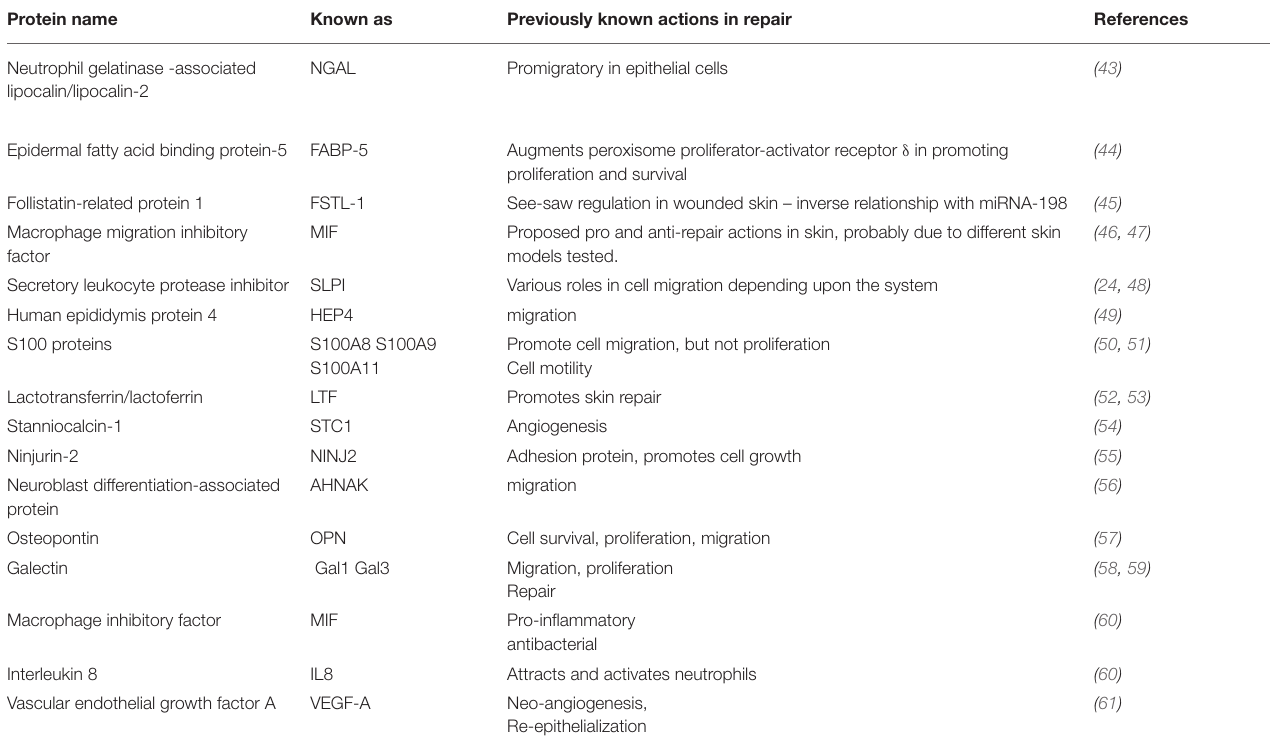
TABLE 1 | Proteins elevated in menstrual fluid vs. peripheral plasma and known to facilitate